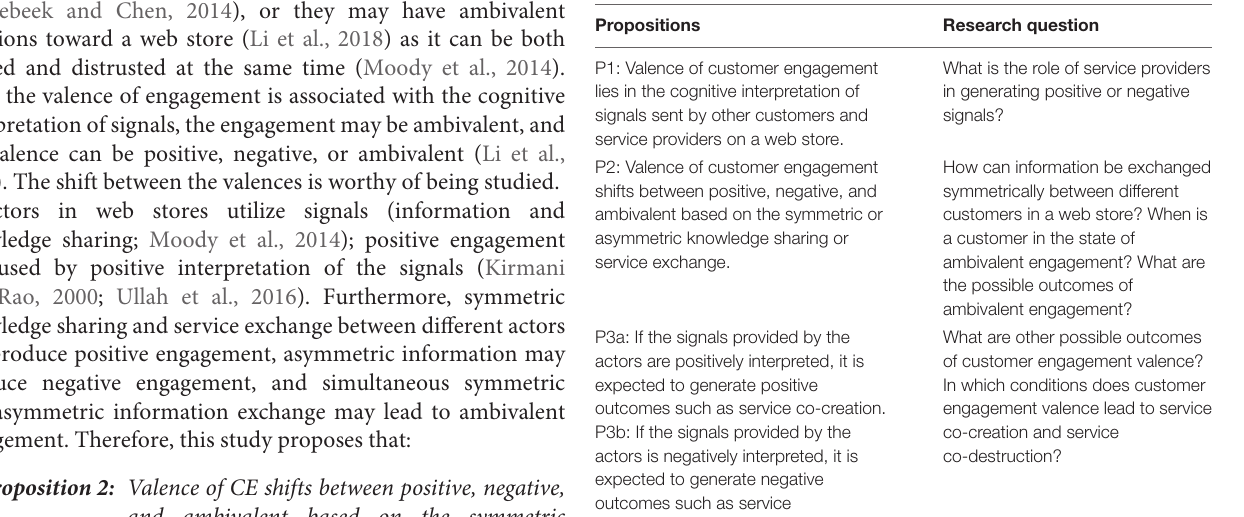
TABLE 2 | Propositions for research